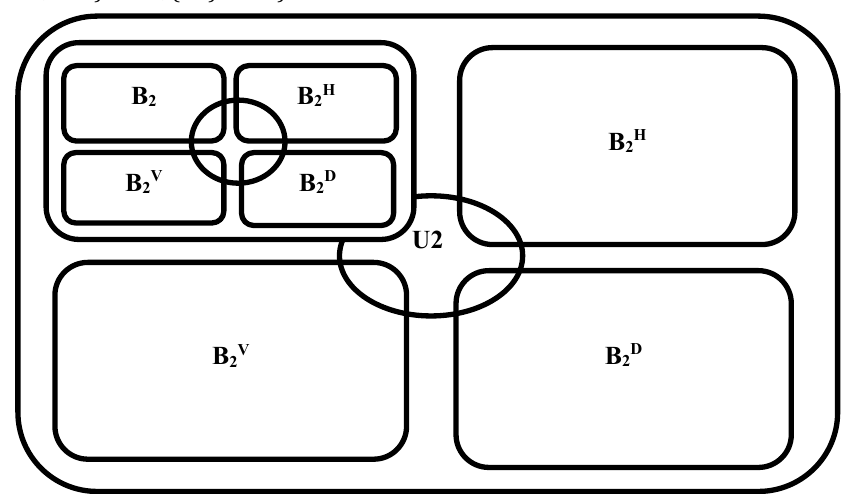
Fig. 2. Structure of the MSVD (Naidu,